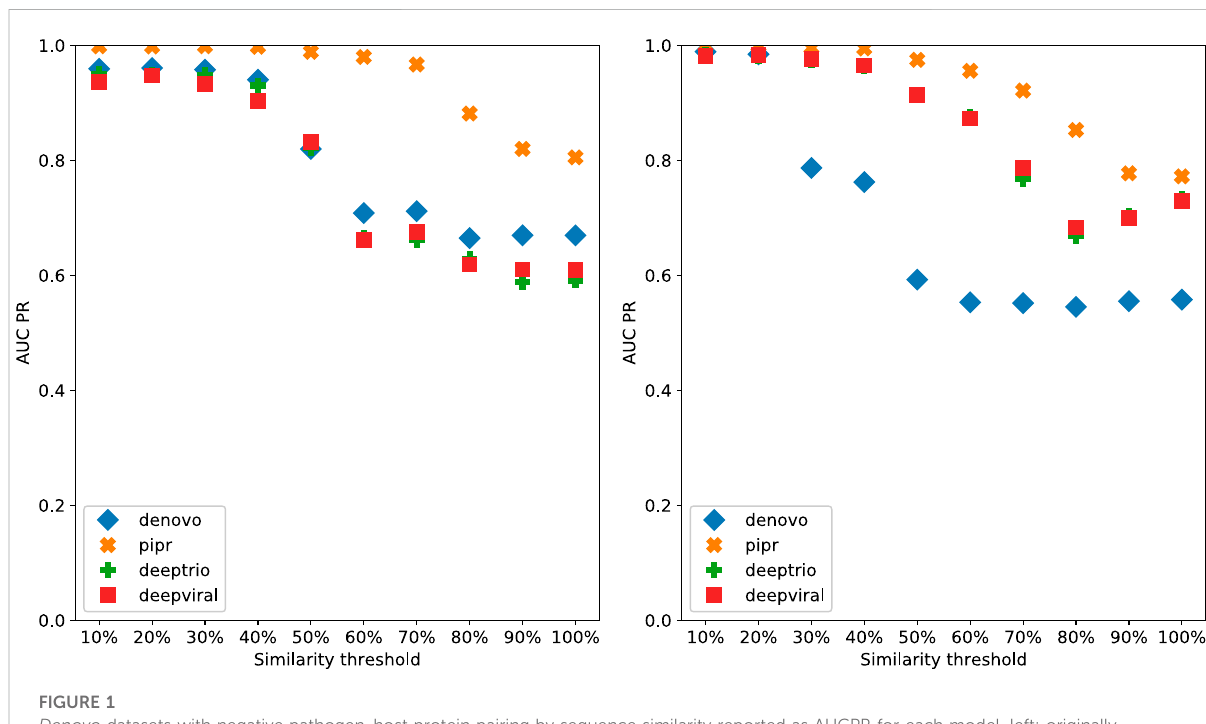
FIGURE 1 Denovo datasets with negative pathogen-host protein pairing by sequence similarity reported as AUCPR for each model, left: originally published Denovo datasets, right: HPIDB based Denovo